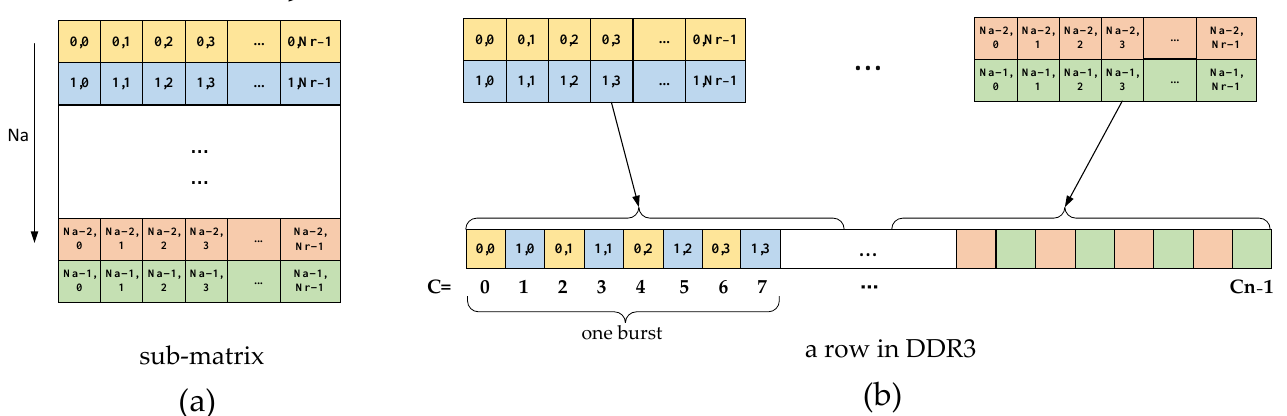
Figure 8. Schematic diagram of sub-matrix data cross-storage method. ( a ) The sub-matrix; ( b ) the data in the sub-matrix are mapped to a row of DDR3 by using the cross-mapping method.